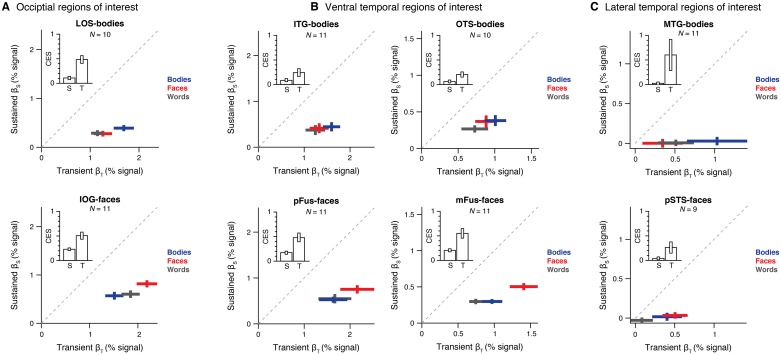
Differential contributions of transient and sustained temporal channels across ventral and lateral regions selective to face and body stimuli.Contributions (β weights) of transient (x axis) and sustained (y axis) channels for each stimulus category estimated by the two-temporal channel A+S model in (A) occipital body-selective region on the lateral occipital sulcus (LOS) and a face-selective region on the inferior occipital gyrus (IOG), (B) ventral-temporal body-selective regions on the inferior temproal gyrus (ITG) and occipito-temporal sulcus (OTS) and face-selective regions on the posterior and mid fusiform gyrus, pFus- and mFus-faces, respectivevely, and (C) a lateral temporal body-selective region on the mid temporal gyrus (MTG) and a face-selective region on the posterior aspect of the superior temporal sulcus (pSTS-faces). Crosses span ±1 SEM across participants in each axis, and β weights were solved by fitting the model using split halves of the data including runs from all three experiments. Data show average model weights across both splits of the data for each participant. Red: response to faces. Blue: response to bodies. Gray: response to words. Dashed line: identity line (βS = βT). Inset: bars indicate mean contrast effect size (CES) of β weights for the preferred vs. nonpreferred categories in each channel ±1 SEM across participants.